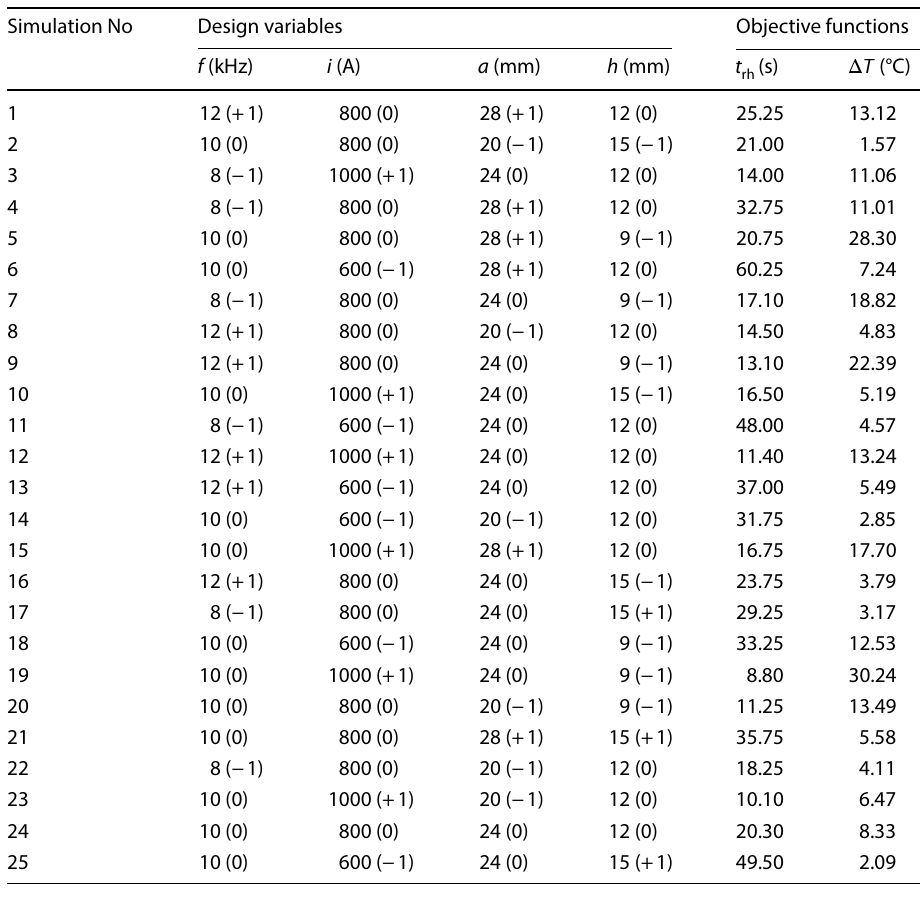
Table 3 Box-Behnken experiment design and corresponding values of objective functions